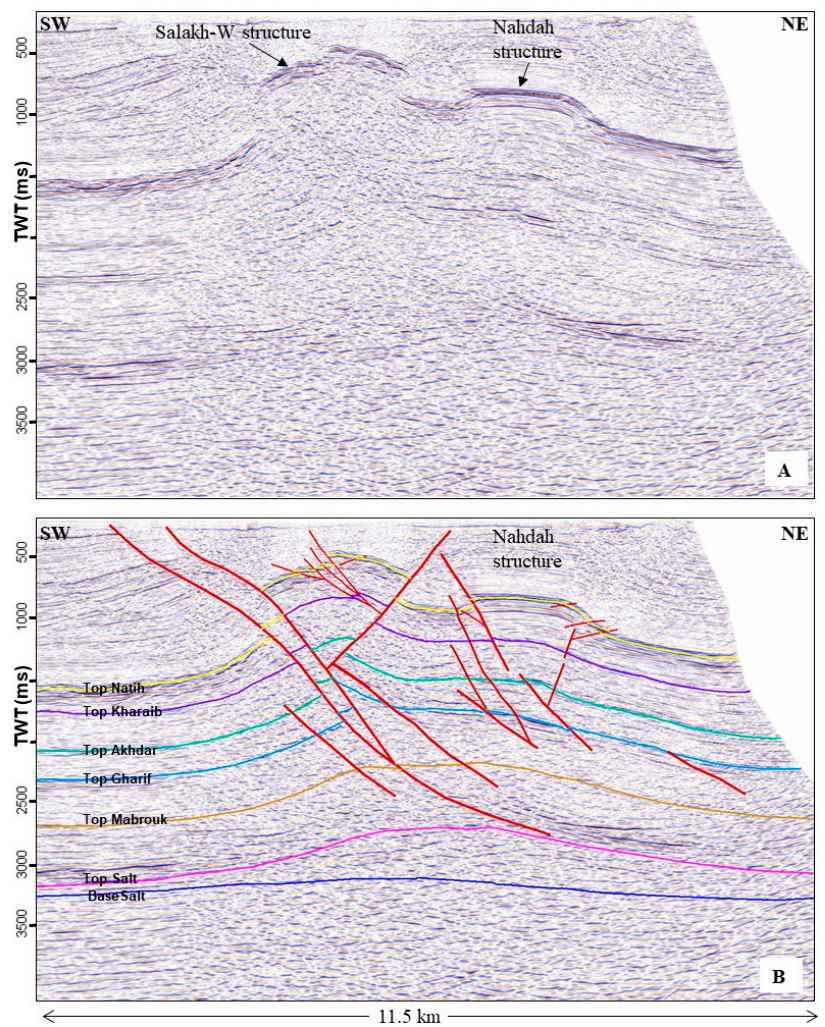
Figure 12. (A) Uninterpreted and ( B ) interpreted sections of seismic line 2. The location of the section is shown in Figure 6. is shown in Figure